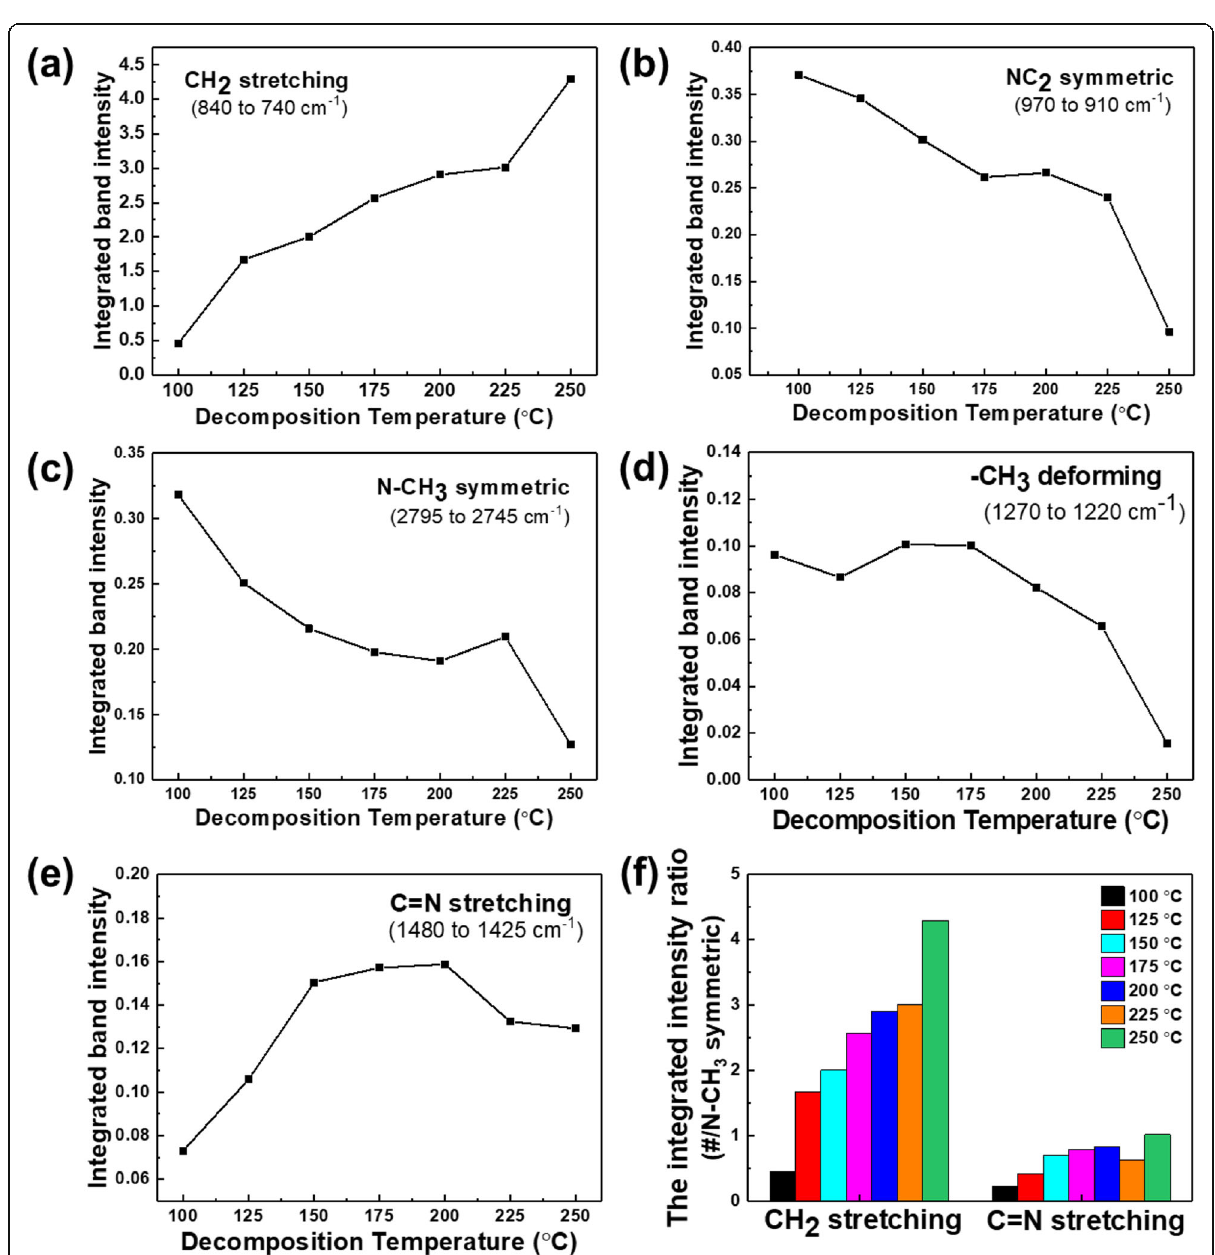
Fig. 3 Integrated band intensity and normalized of CpZr(NMe 2 ) 3 spectra main peak focus on spectra region a – CH 2 – stretching (840 to 740 cm − 1 ), b NC 2 symmetric (970 to 910 cm − 1 ), c N – CH 3 symmetric (2795 to 2745 cm − 1 ), d – CH 3 deforming (1270 to 1220 cm − 1 ) and e C=N stretching (1480 to 1425 cm − 1 ) bands, f the integrated intensity ratio of main peak/N – CH 3 peak